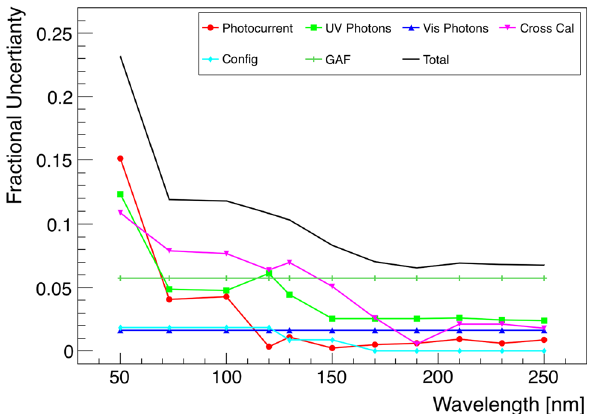
Fig. 19 The extracted QE of TPB as a function of incident wavelength (right axis). This is plotted alongside WLSE results shown in Fig. 16. These quantities are plotted on different axes because of their funda- mentally different definitions